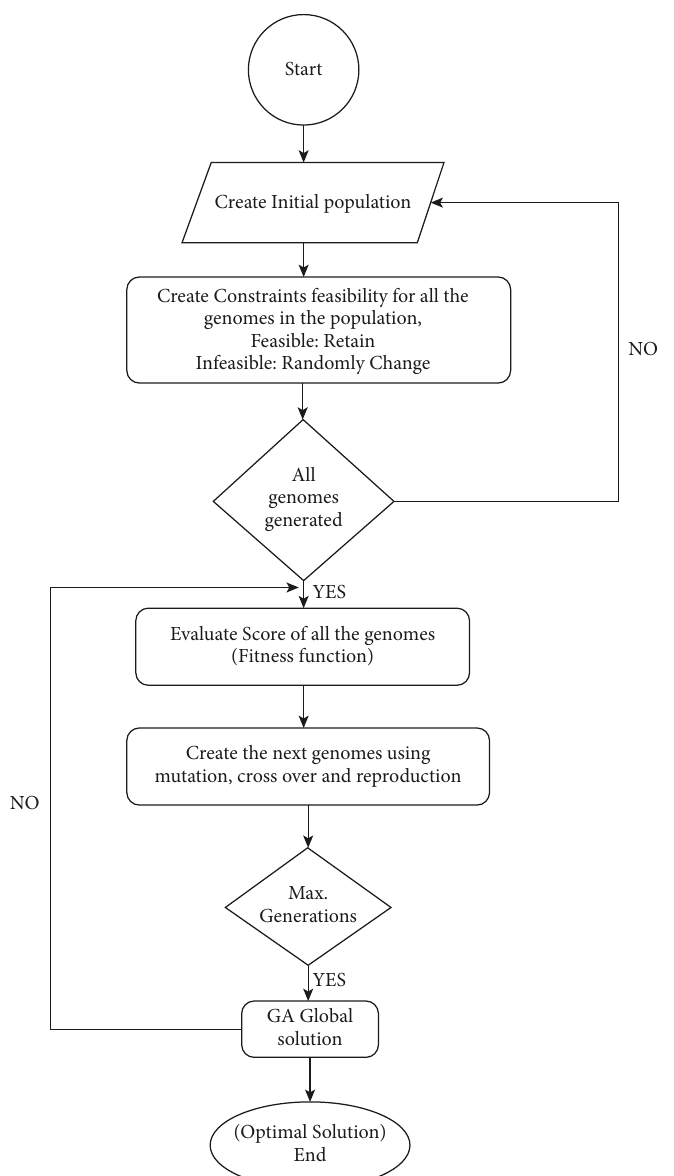
Figure 5: The GA optimization algorithm flowchart.